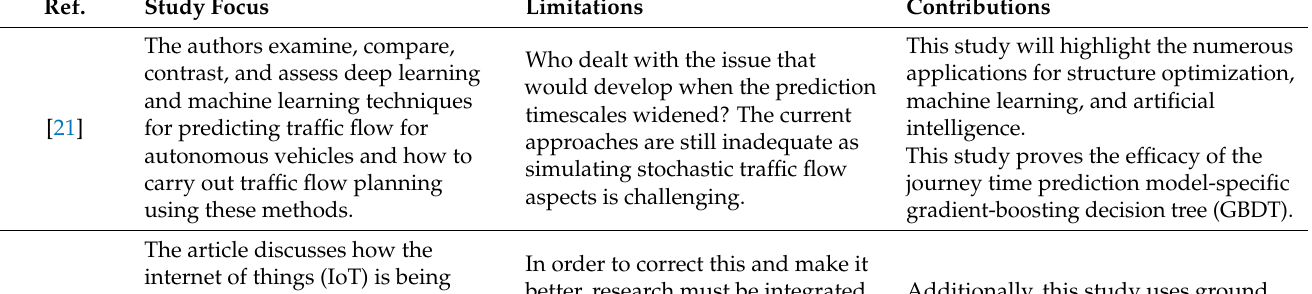
Table 1. Limitations of some associated reviews and